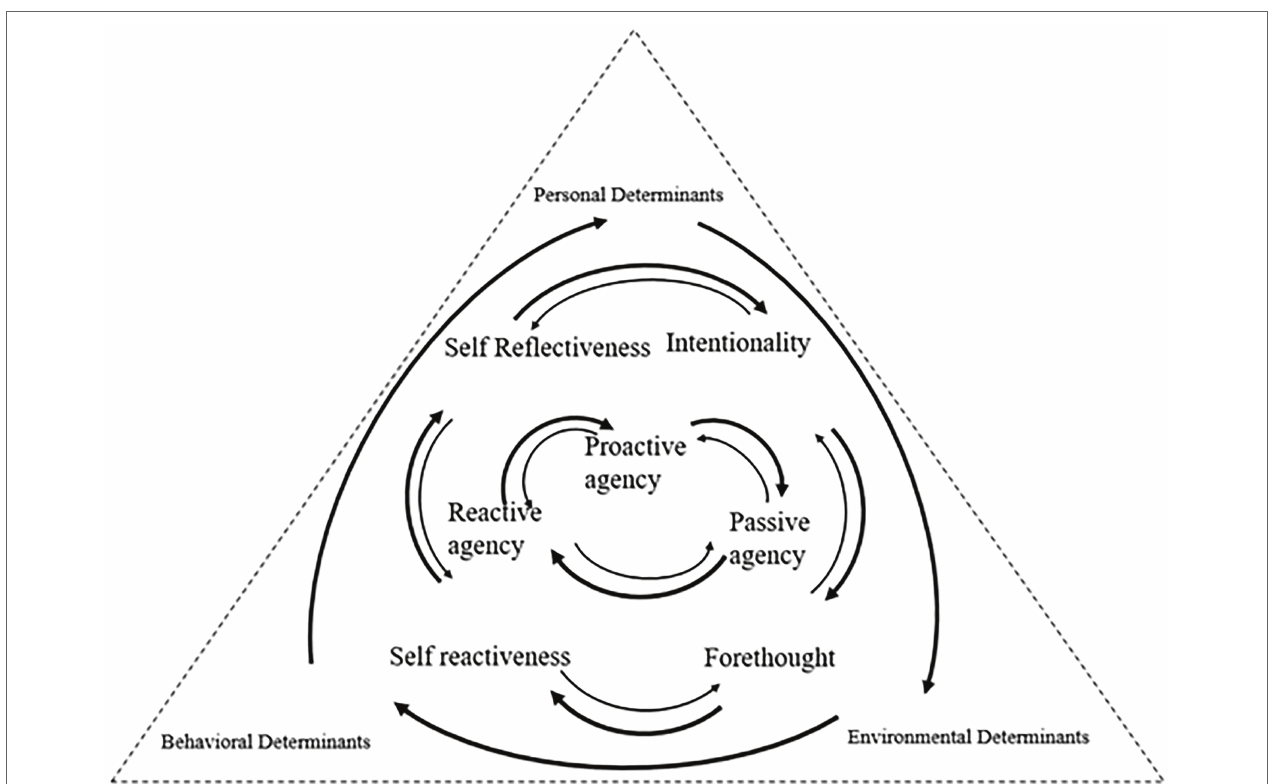
FIGURE 2 | A proposed three-layered Triadic Reciprocity Framework on teacher agency (based on Jenkins, 2020, p.